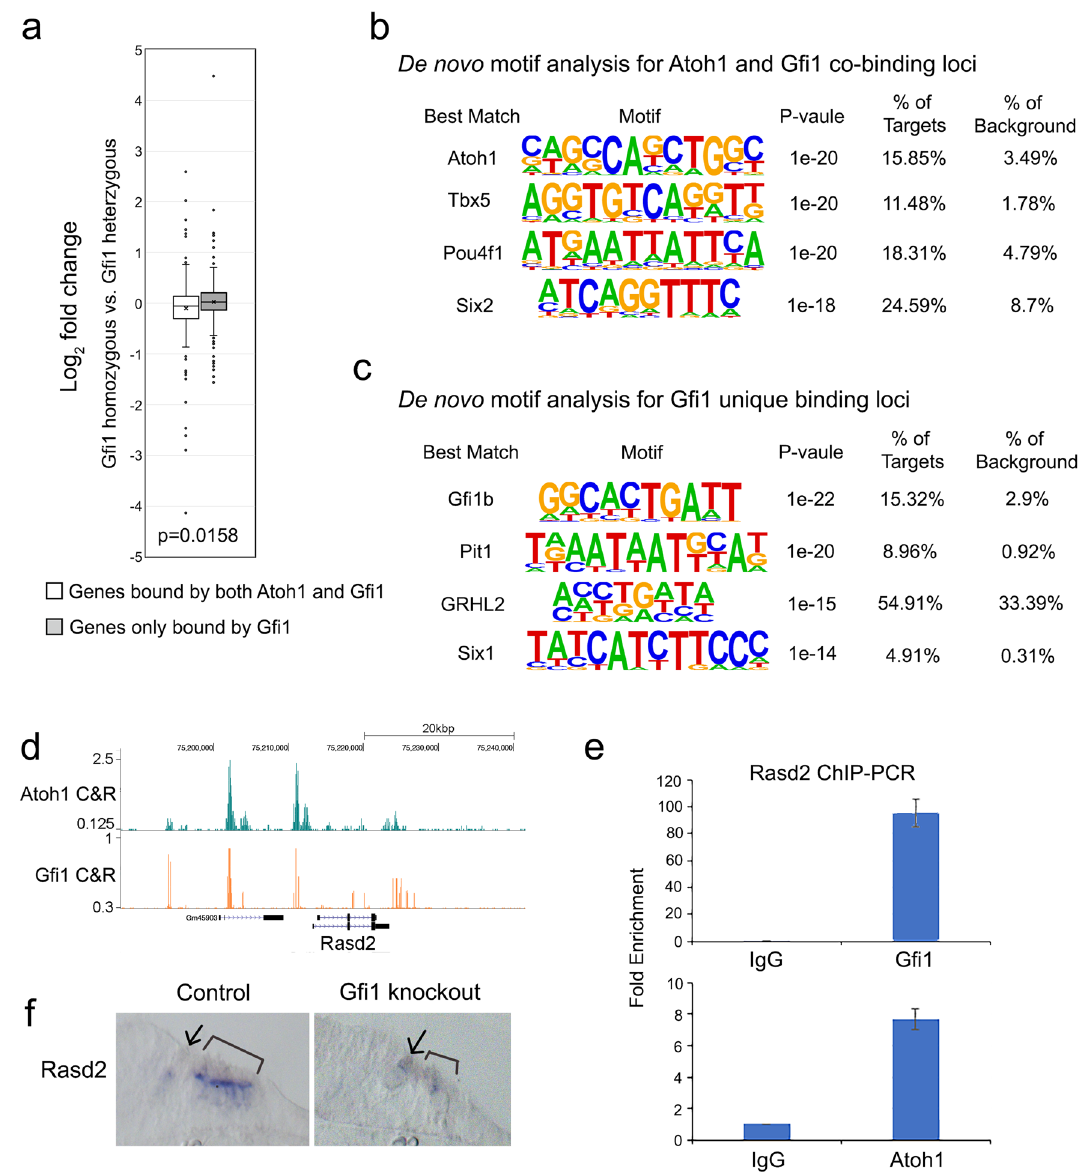
hair cells (i.e. positively regulated by GFI1), while genes bound by only GFI1 are more likely to be up-regulated in Gfi1 mutant hair cells (i.e. negatively regulated by GFI1). Statistical significance was assessed by a Student t-test, comparing the log 2 fold change (FC) values. ( b ) De novo motif analysis of the 386 loci bound by both ATOH1 and GFI1. Although ATOH1 DNA recognition motifs are highly enriched in these peaks, Gfi1 DNA recognition motifs are not. ( c ) De novo motif analysis of the 350 loci bound by only by GFI1. Here, the most highly enriched motif is a GFI1b recognition motif. ( d ) Genomic browser track of CUT&RUN sequencing showing both ATOH1 and GFI1 bind to loci near the hair cell gene Rasd2 . ( e ) ChIP-QPCR analysis of ATOH1 and GFI1 binding to the same distal regulatory elements in the Rasd2 gene. Cochlear epithelium from neonatal Atoh1-GFP mice were processed for ChIP using antibodies for GFP (to pull down ATOH1-bound DNA) and GFI1, with IgG as a negative control. ( f ) In situ hybridization of Rasd2 mRNA in P0 Gfi1 wild type and mutant cochlea. Arrow marks inner hair cells, brackets mark the outer hair cell